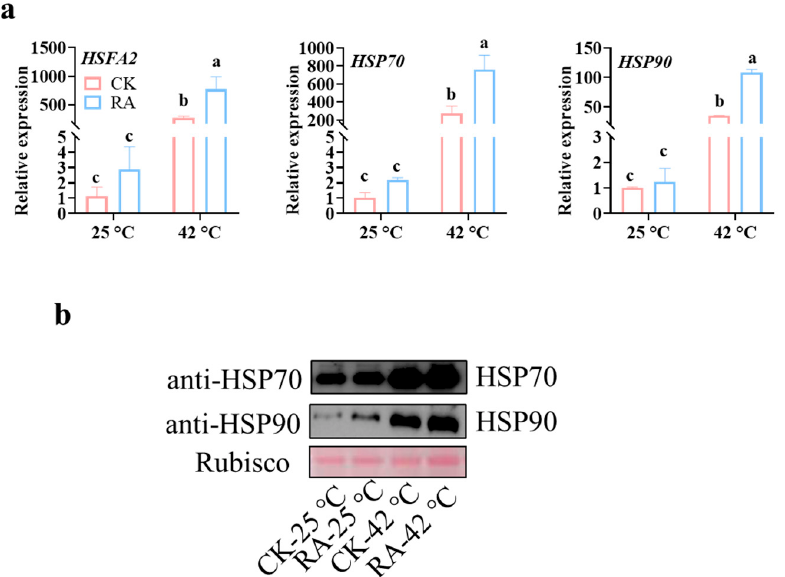
Figure 3. RA treatment promotes the transcription and protein abundance of tomato HSPs in response to high temperatures. ( a ) Effects of RA treatment on transcript abundance of HsfA2, HSP70, and HSP90 in tomato plants subjected to normal temperature (25 ◦ C) or high temperature (42 ◦ C) for 1 h. ( b ) Effects of RA treatment on the protein abundance of HSP70 and HSP90 in tomato plants with 6 h of different temperature treatments. The data presented are the mean values ± SD, n = 3. Statistically significant differences between treatments ( p < 0.05, Tukey’s test) are shown by different letters.